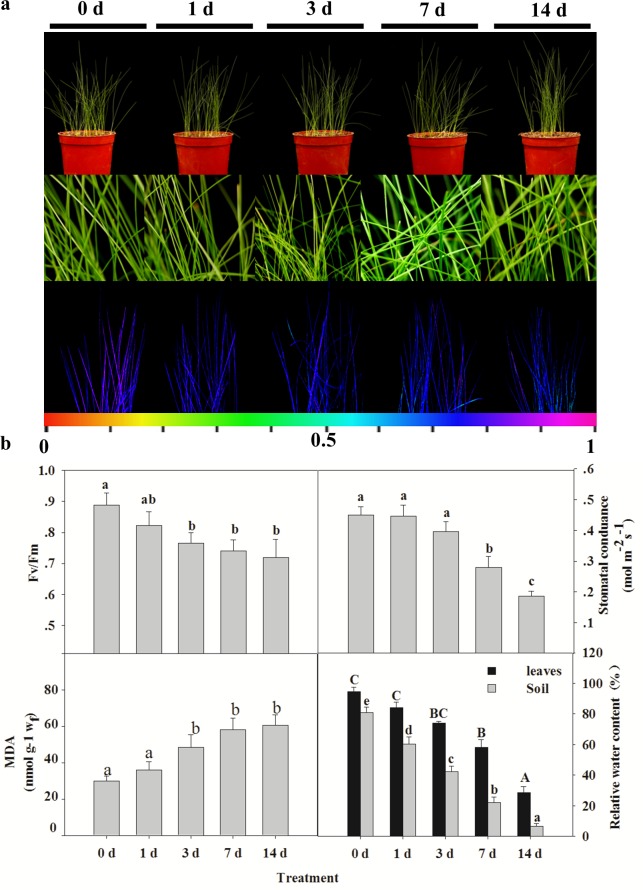
Effects of drought stress on growth of S. purpurea seedlings.(A) Leaf phenotypes of S. purpurea following exposure to drought stress. Images were acquired at indicated times during the drought treatment (top); enlarged images (middle); photosynthetic capabilities recorded by Fv/Fm imaging using a PAM chlorophyll fluorometer (bottom). Pseudocolor code depicted at the bottom of the images ranges from 0 (red) to 1.0 (purple). (B) Effects of drought stress on photosynthetic Fv/Fm ratio, stomatal conductance, and MDA content of S. purpurea seedlings. Relative water content (RWC) of soil and S. purpurea seedlings were measured as described in “Materials and Methods”. Data are mean values ± SE obtained from three independent experiments (n = 15). Different letters within a column indicate significant differences (p<0.05; one-way analysis of variance and Tukey’s test).